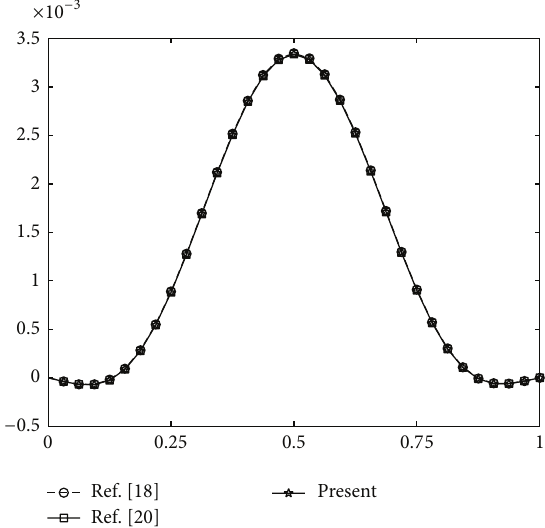
Figure 2: Numerical solutions at 𝑡 = 10 , ℎ = 1/32 , 𝜏 = 0.1 , 𝛽 = 1 , 𝛼 = 2 , and 𝑝 = 8 .